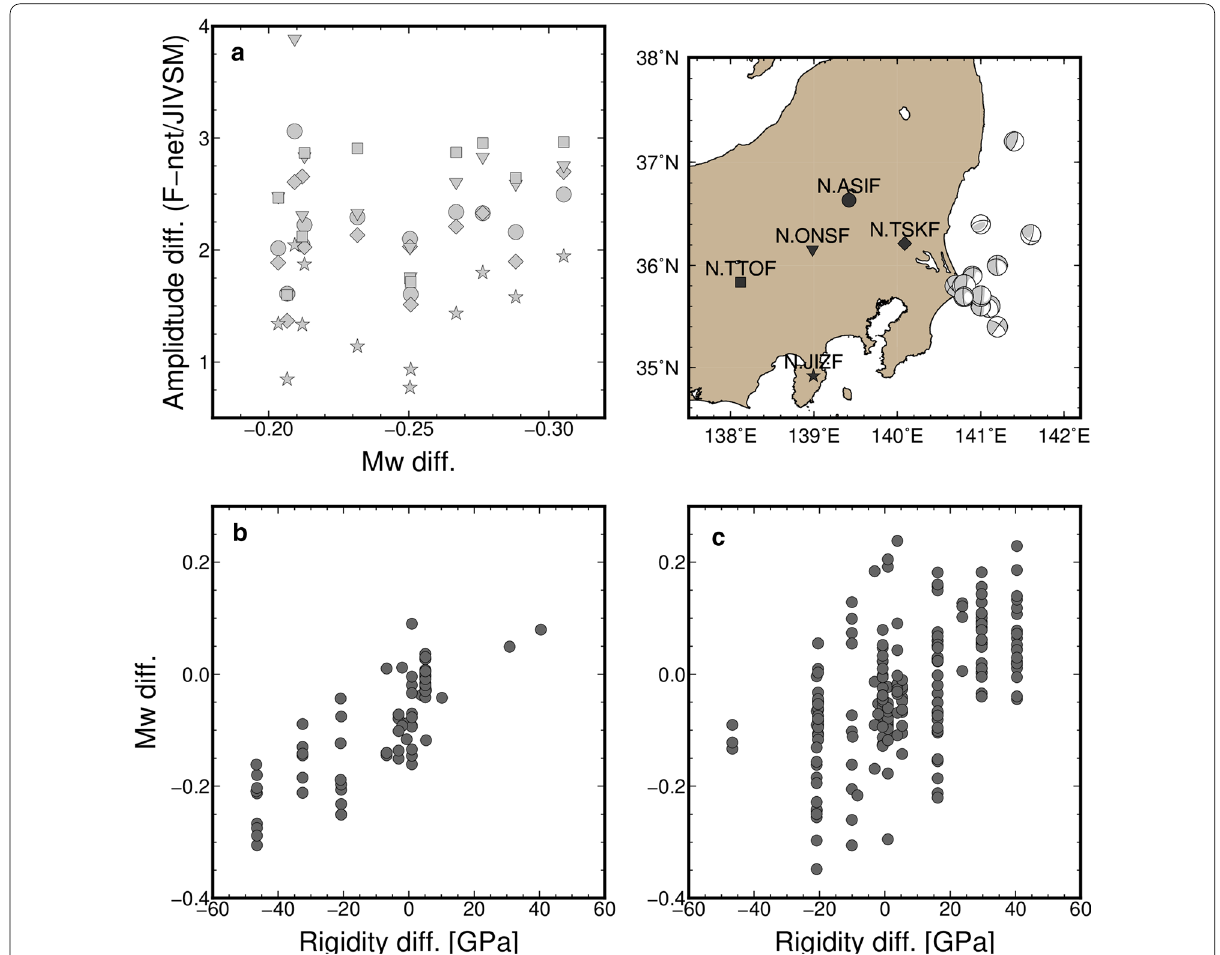
Fig. 7 Amplitude and Mw differences between the JIVSM and F-net 1D model. a Amplitude differences of simulation results from the JIVSM and F-net 1D models. Circle, diamond, inverse triangle, square, and star represent amplitude ratio or station location of N.ASIF, N.TSKF, N,ONSF, N.TTOF, and N.JIZF, respectively. Amplitudes ratios were calculated by dividing maximum amplitudes of simulations using the F-net 1D model by those using the JIVSM. Maximum amplitudes were measured using vertical seismograms for periods of 25–100 s. The relationships between Mw differences and rigidity structures in ( b ) Kanto and ( c ) Nankai regions. The rigidity differences were evaluated by differences of the JIVSM rigidities at centroid depths from the F-net 1D model. The Mw differences in ( c ) was made from the data of Takemura et al.